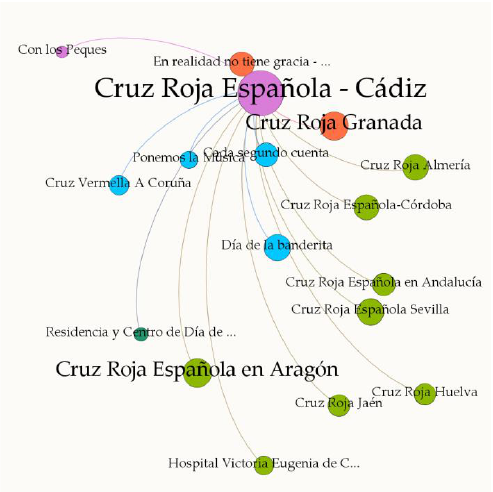
Figure 3. Display of the RCC ’s Facebook network with a “Mutual Edge” filter.